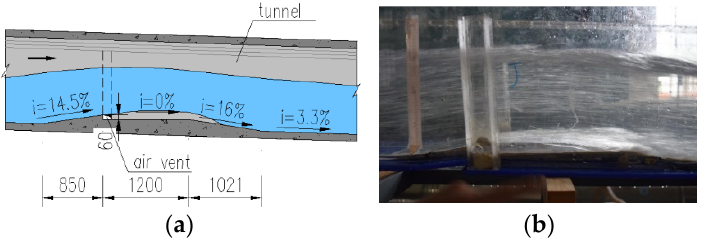
Figure 7. Group 11 shape design and flow pattern (Unit: cm): ( a ) the design aerator shape of Rumei; ( b ) flow pattern.